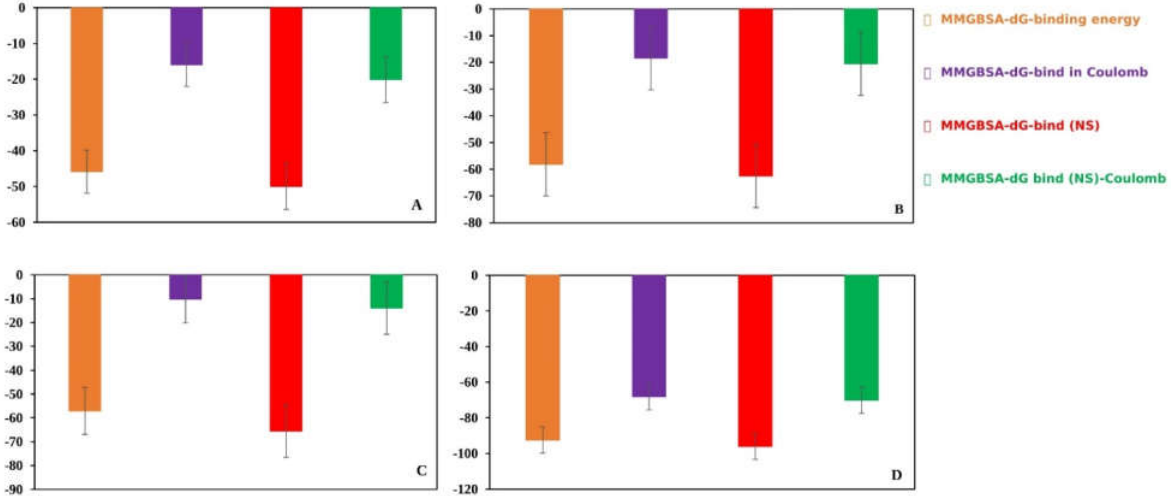
Figure 11. Different energy components and net MM-GBSA binding free energy (kcal/mol) along with the standard deviation values calculated from 100 ns MD simulation trajectory of FAK1 protein in complex with the selected compounds ( A ) CID: 24601203, ( B ) CID: 1893370, and ( C ) CID: 16355541 and ( D ) control.